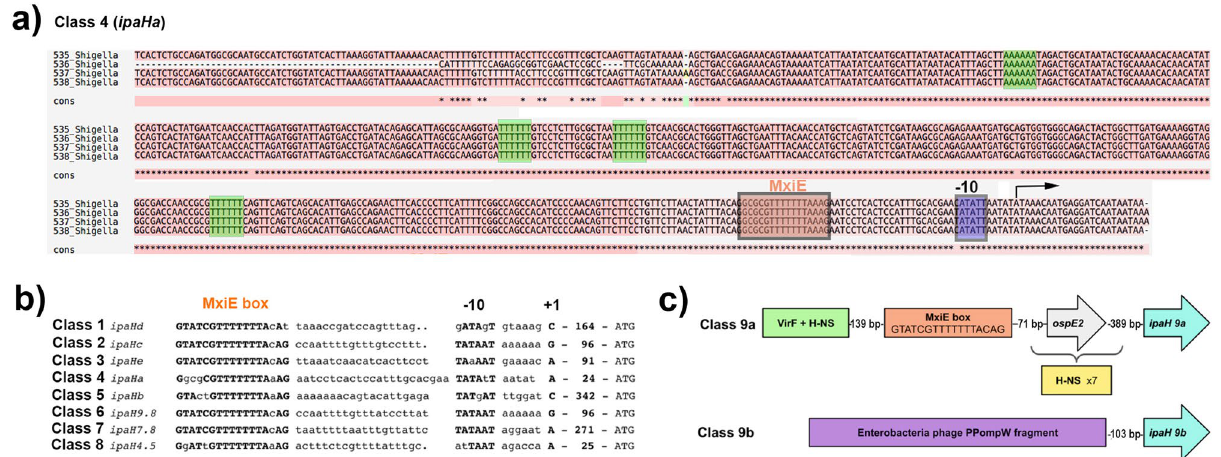
Figure 2. Regulatory elements in ipaH upstream regions ( a ) Alignment of the upstream region for selected representatives of the ipaH class #4. Representatives have been selected based on their sequences so that all sequence variants are presented. The putative MxiE box is indicated by the orange box, A/T tracks are in green boxes. The transcription start is indicated by the black arrow. ( b ) Comparison of the sequence-based ipaH classification with the classification based on positioning of the MxiE box, − 10 element, and the sequence of the spacer. Adapted from 34 . ( c ) Principal scheme of upstream regions of the ipaH classes #9a and